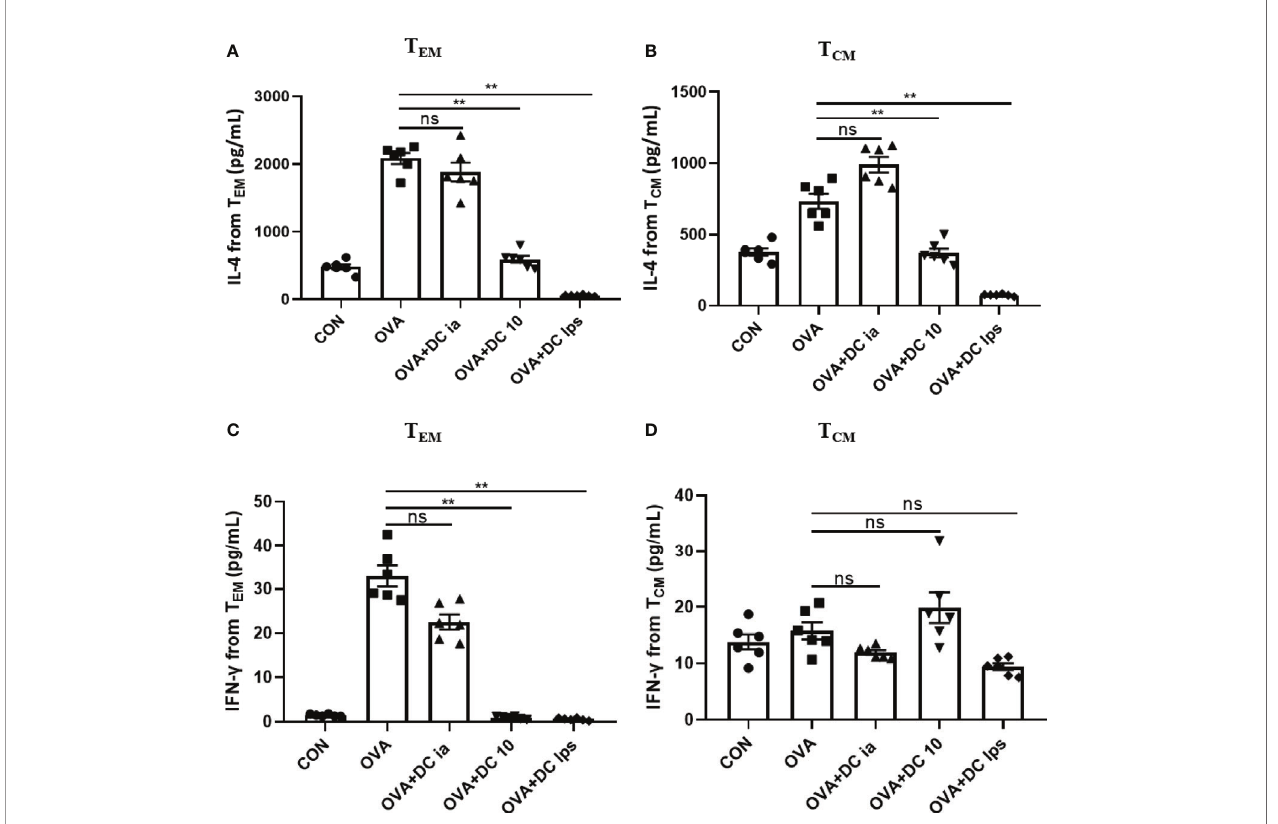
FIGURE 6 | Adoptive transfer of DClps changed the cytokine releasing ability of pulmonary memory CD4 + T cell. (A) IL-4 released from pulmonary T CM andT EM determined byELISA. (B) IFN- g released from pulmonaryT CM and T EM determined byELISA. The columns and error bars represent the meanandSEM. (**P < 0.01, ns, no signi fi cant difference, ANOVA with Tukey ’ s post hoc analysis). The same experiment was repeatedthree times with similar results (n= 5 ineach